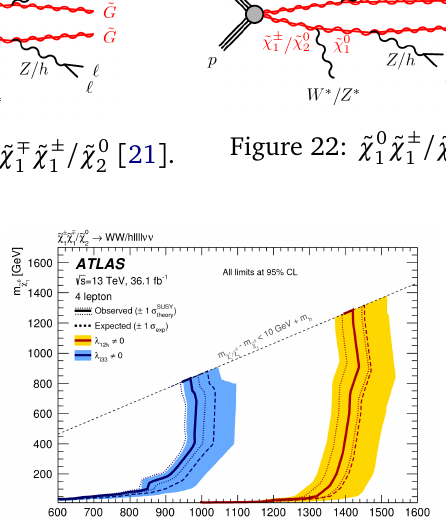
/ ˜ ν NLSP Figure 19: ˜ l L [ 21 ] .